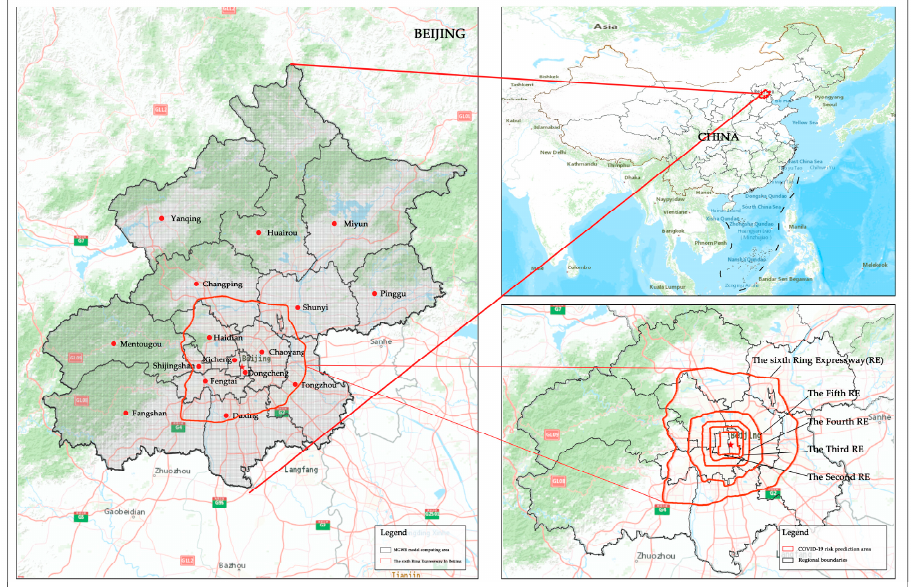
Figure 2. Study area of this paper.